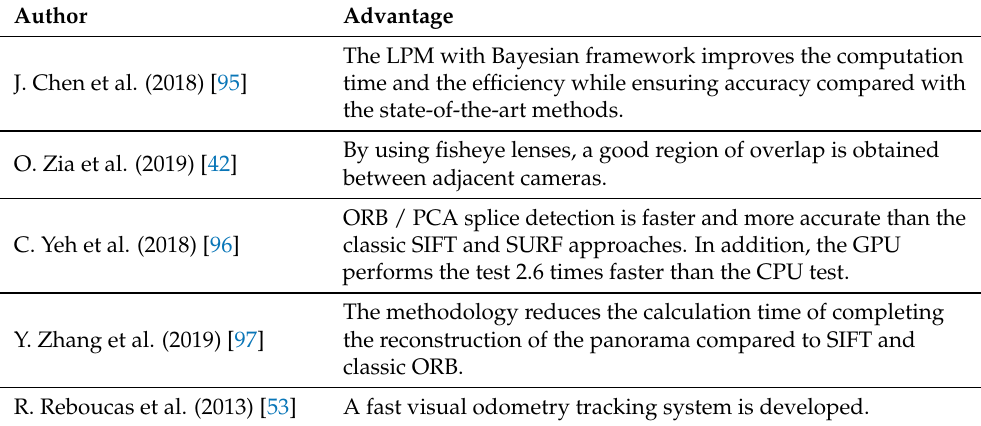
Table 5. ORB applied on UAVs.